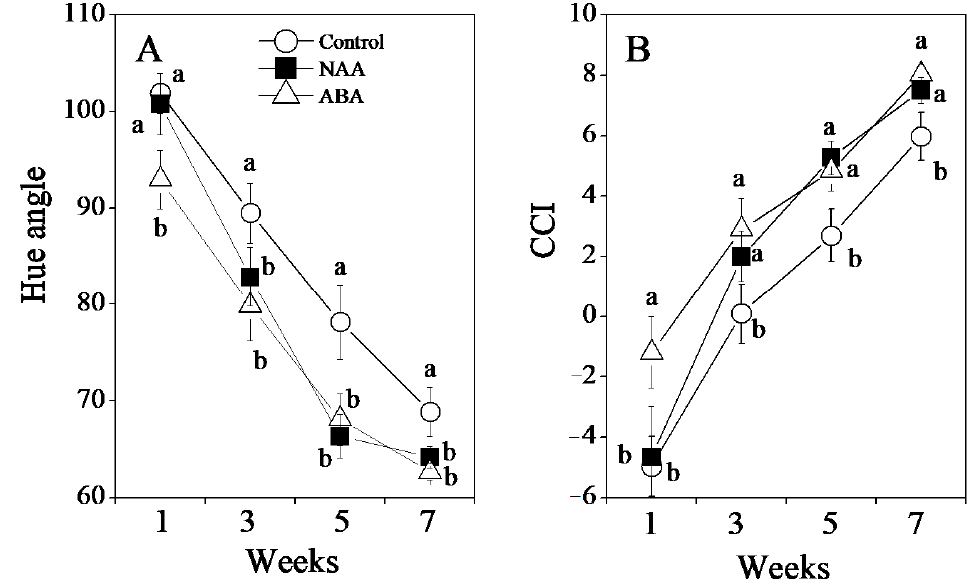
Figure 3. Effect of NAA and ABA on ( A ) hue angle and ( B ) citrus color index (CCI) in GA and PDJ-treated citrus fruit. The results shown are the mean ± SE ( n = 6). Different letters (a and b) indicate significant differences at the 5% level by Tukey’s test.